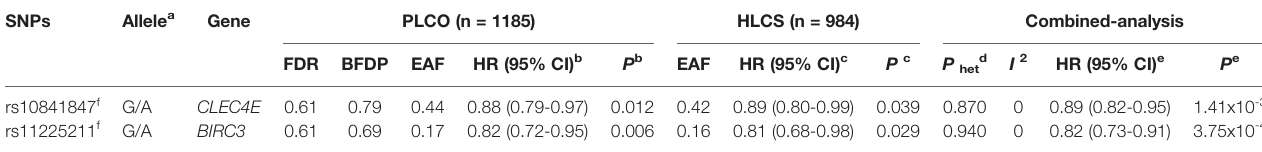
TABLE 2 | Associations of two signi fi cant SNPs with overall survival of patients with NSCLC in both discovery and validation datasets from two previously published GWASs.